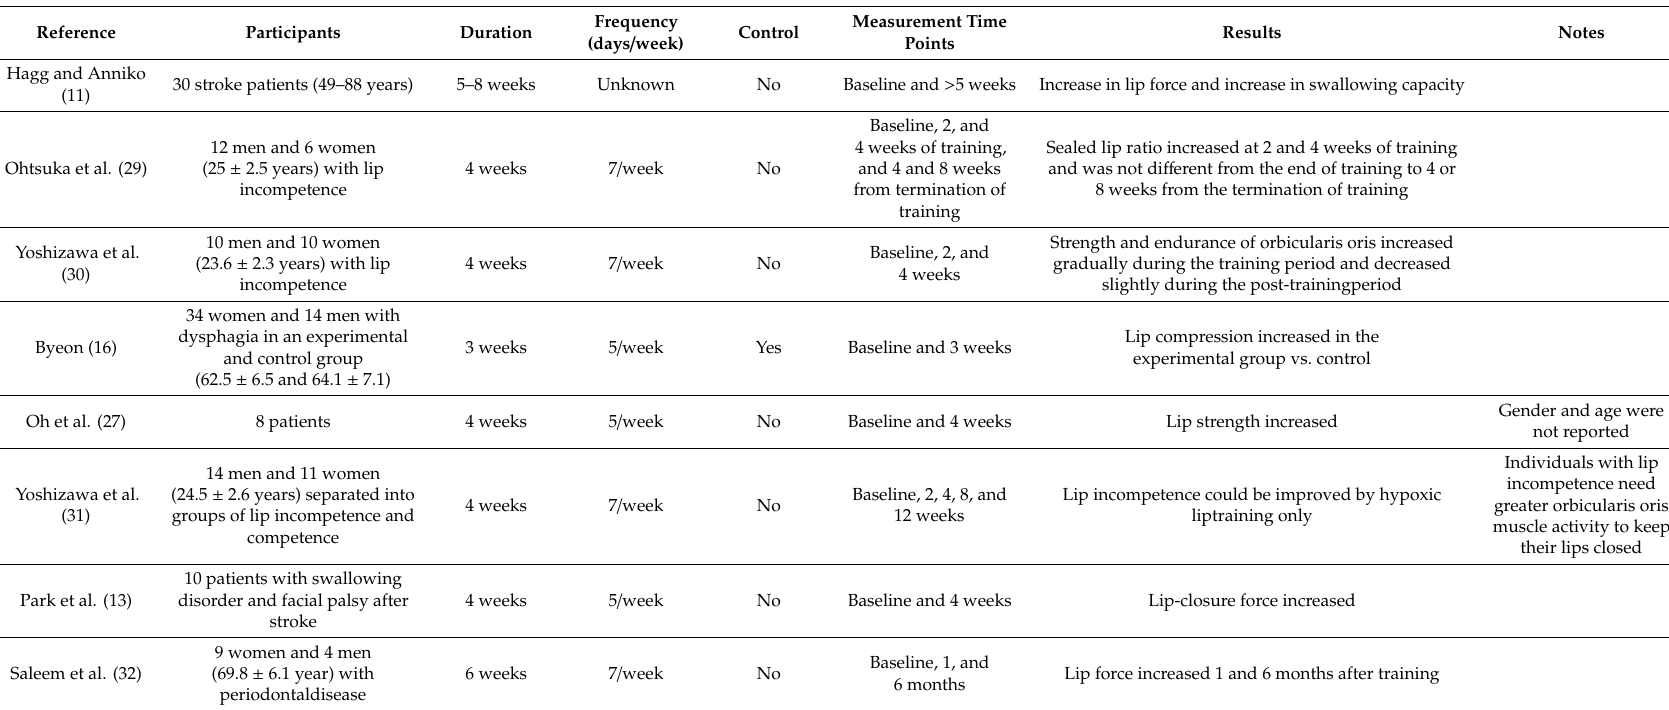
Table 2. Lip strength training in adults with health